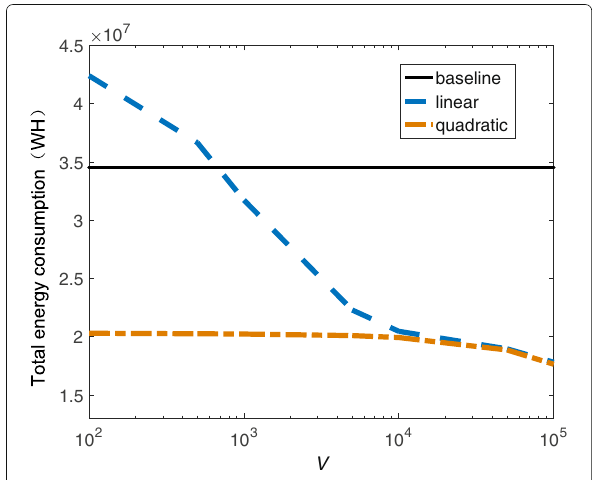
Fig. 7 Comparison of total energy consumption under different control policies